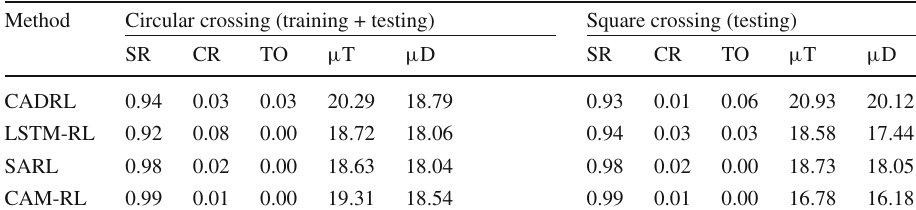
Table 3 Quantitative results of robot navigation trained in circular crossing and tested in square crossing scenarios with ten humans